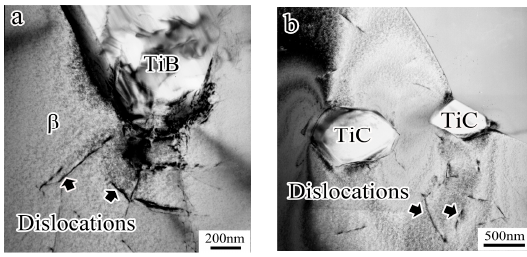
Figure 7. TEM images of the reinforcements in alloy A after isothermal compression ( a ) TiB ( b ) TiC.